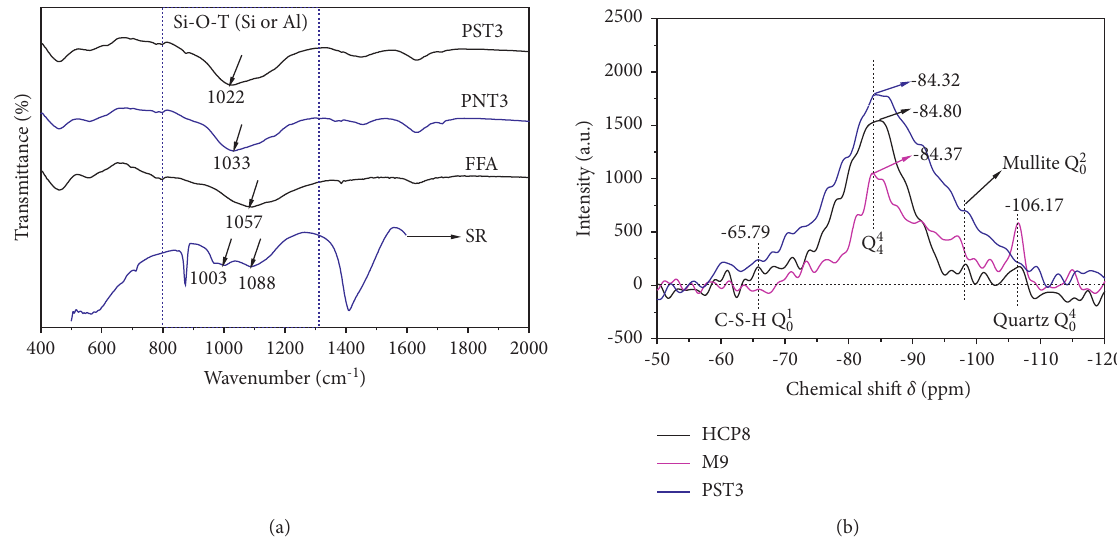
Figure 6: (a) FTIR spectra and (b) 29 Si NMR spectra of sample PST3 and controls (PNT3, HCP8, and